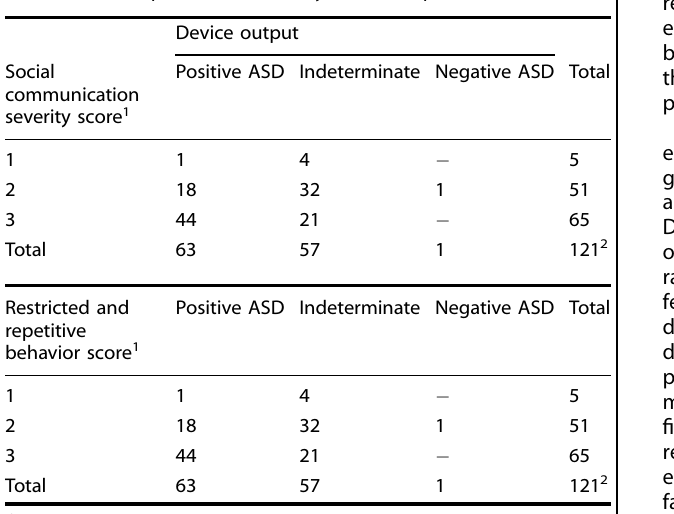
Table 5. ASD severity level scores — social communication and restricted and repetitive behavior by device output.